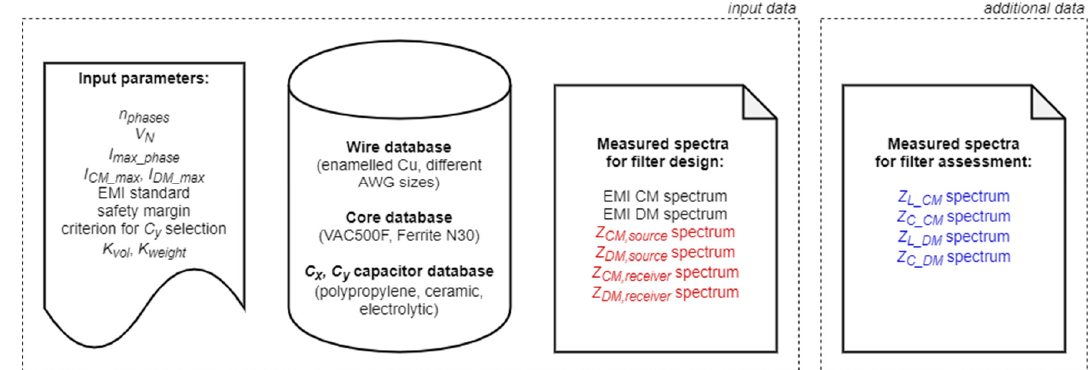
Figure 8. Input data and additional data used in the proposed procedure.